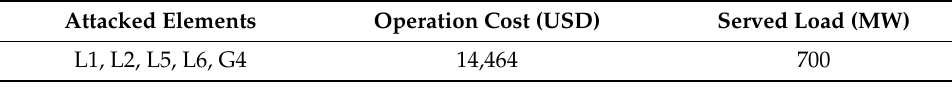
Table 7. Description of the attack plan.